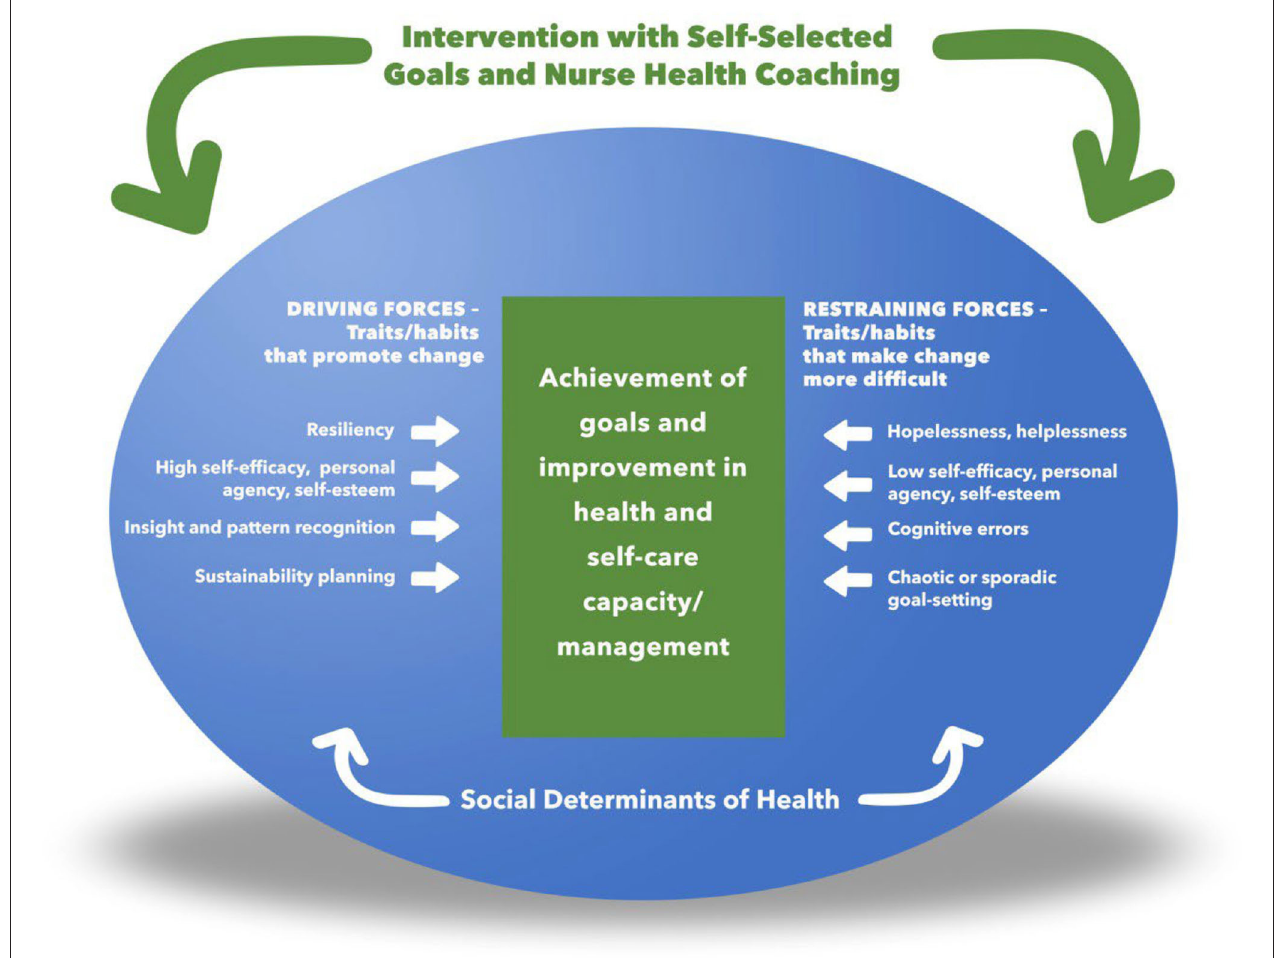
FIGURE 2 | A Model of personalized framework for nurse health coaching [adapted from the concepts of Lewin Field Theory (45)].